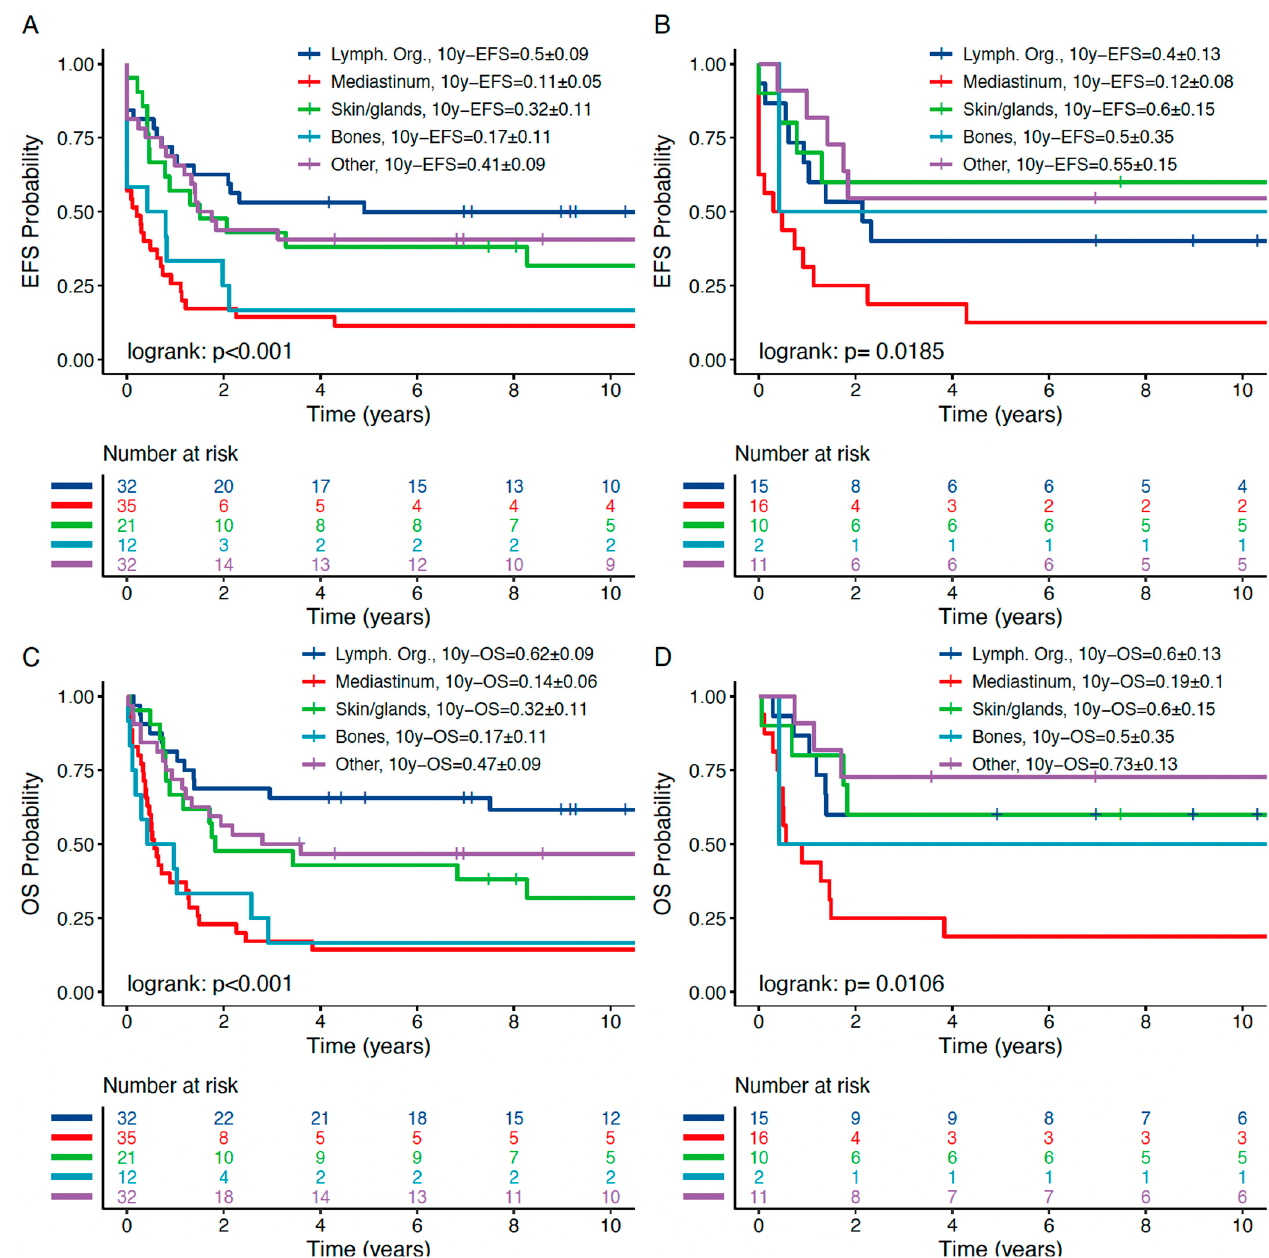
Figure 4. Ten-year pEFS ( A , B ) and pOS ( C , D ) of OEMR subgroups; ( A , C ): pEFS and pOS of combined bone marrow and isolated OEMR; ( B , D ): pEFS and pOS of isolated OEMR. Mediastinal and bone OEMR demonstrate inferior outcome compared to all other subgroups. Calculation based on Kaplan–Meier analysis. p < 0.05.